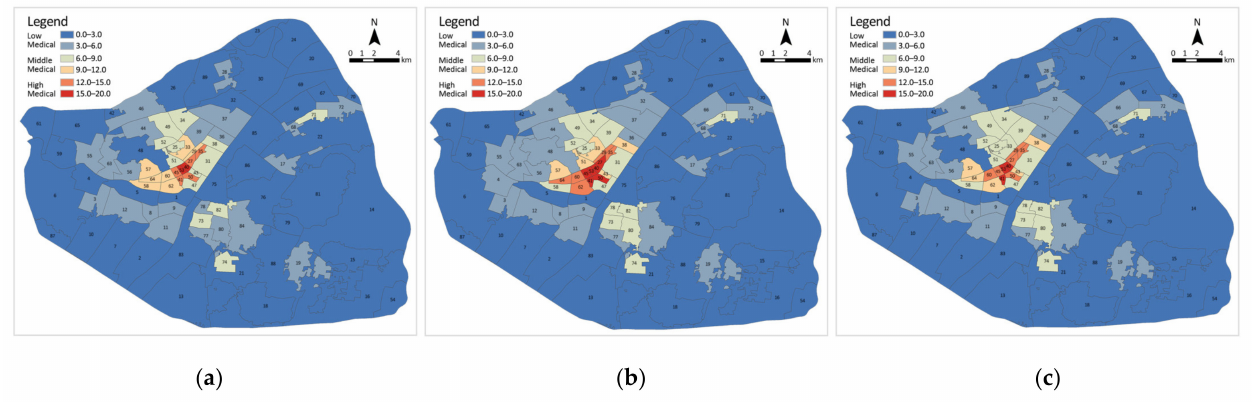
Figure 10. Distribution of the coverage ratio of medical facilities on a subdistrict scale: ( a ) Stage A; ( b ) Stage B; ( c ) Stage